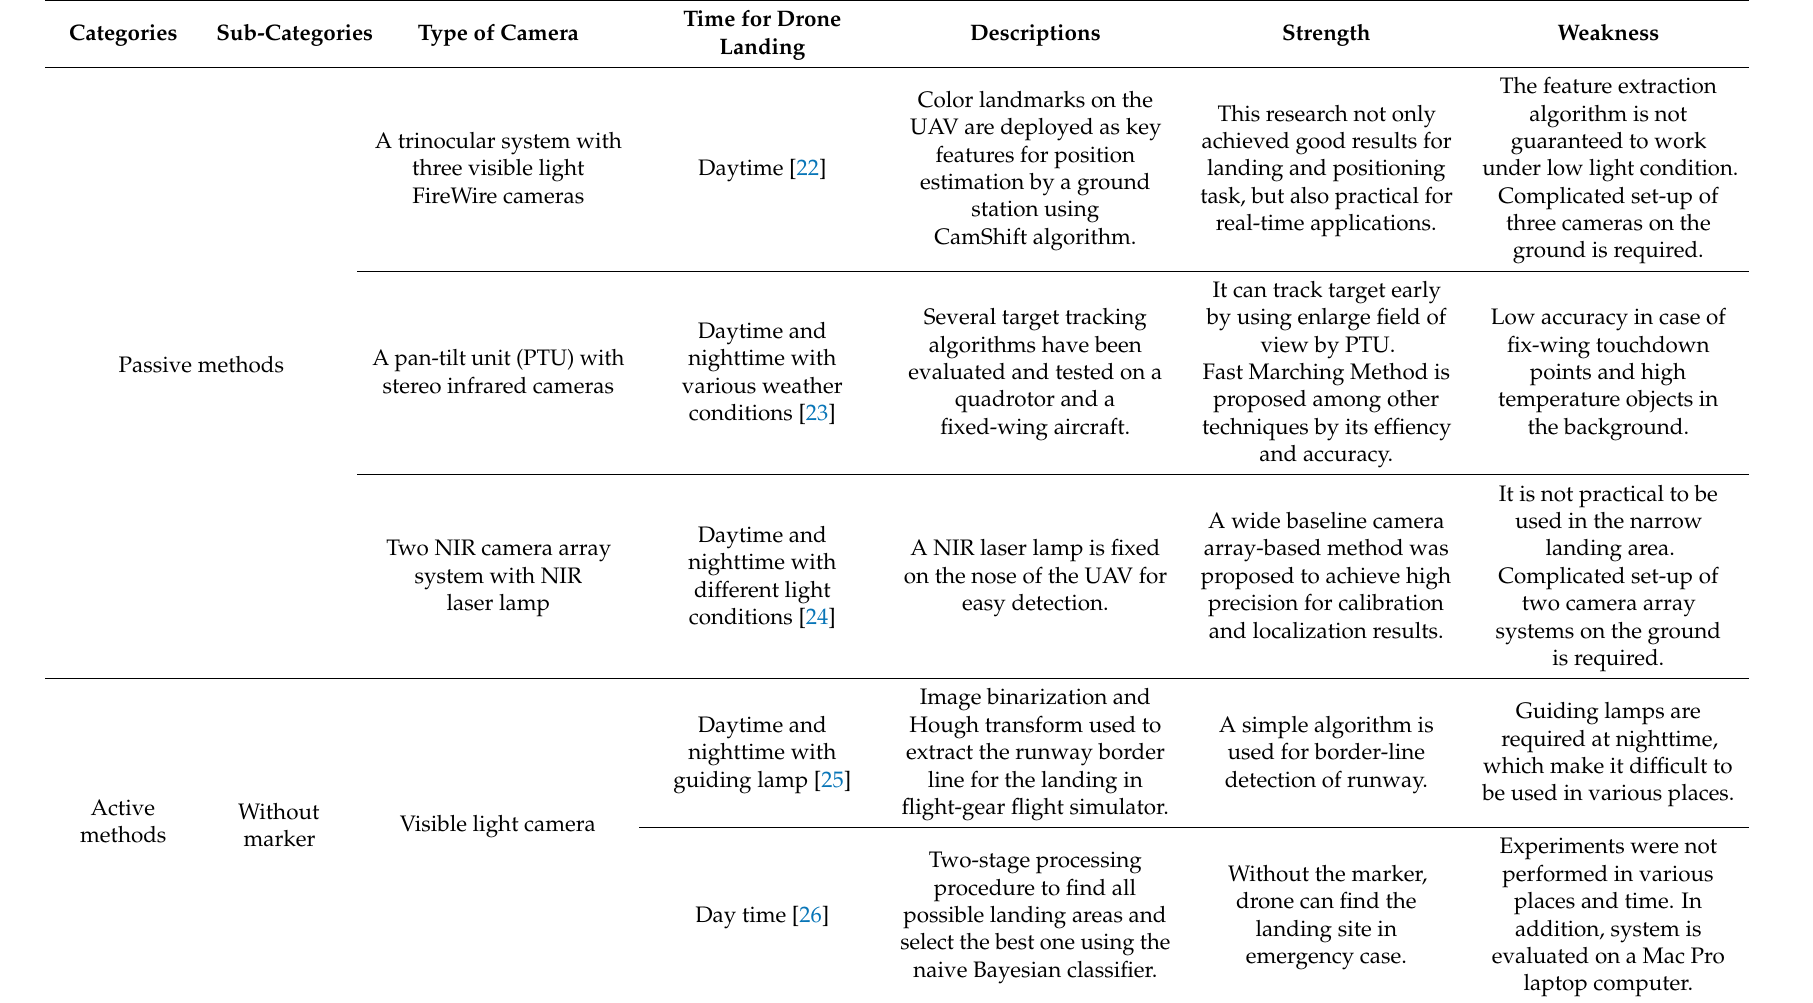
Table 1. Summary of comparisons of proposed and previous